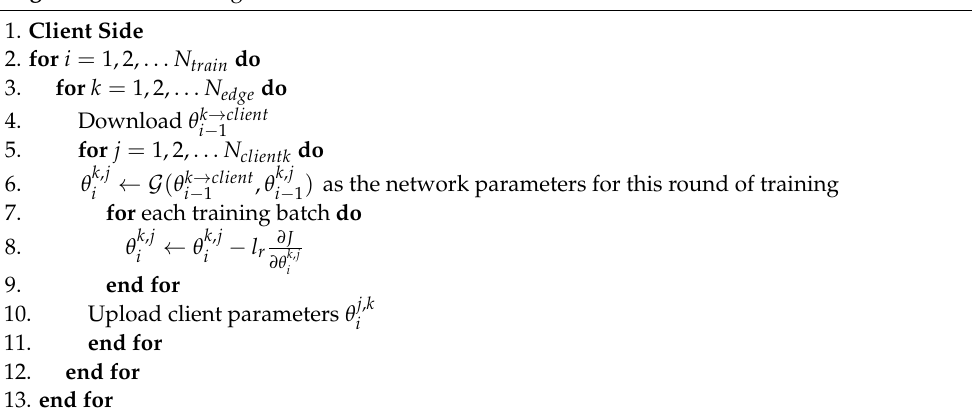
Algorithm 2: i -MFN algorithm for client side